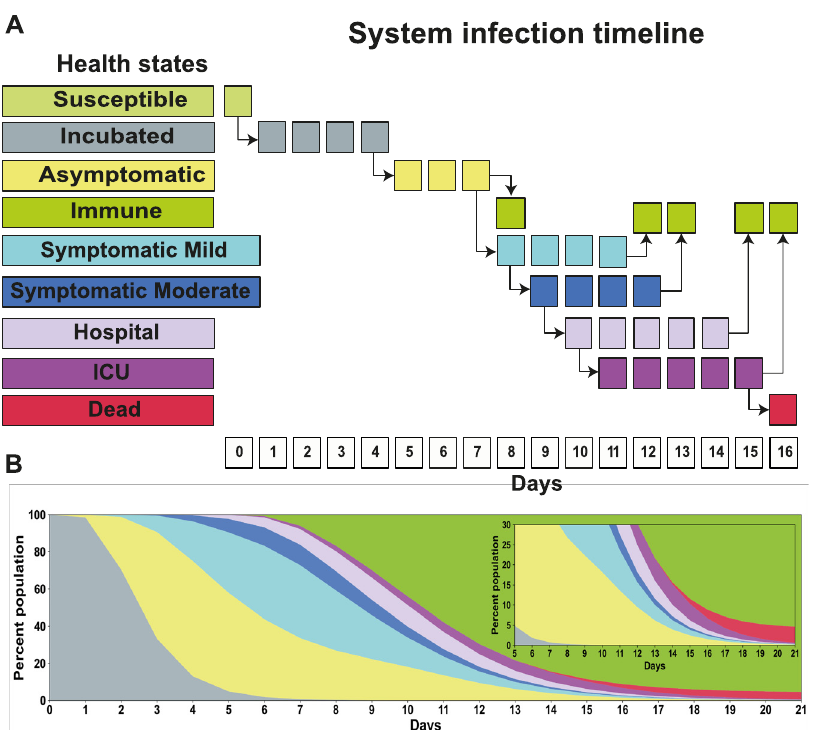
Fig 1. Timeline of agent’s health state progression through a SARS-CoV-2 infection. (A) Possible daily transitions of one agent starting from Susceptible up to Dead or Immune . Sequences of the same state represent average time without change. (B) The evolution of the state of 10,000 agents, with age and sex distribution suited to the City of Natal, turned into Incubated at day zero. The simulation assumes illimited ICU bed availability.